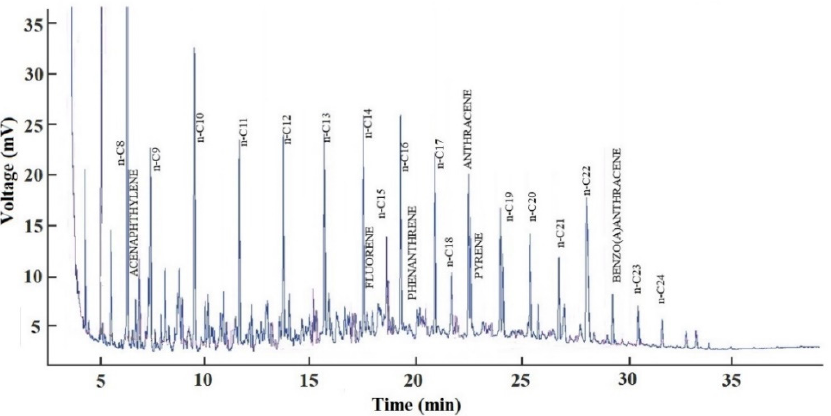
Figure 1. Chromatogram of the commercial diesel oil used in the study.